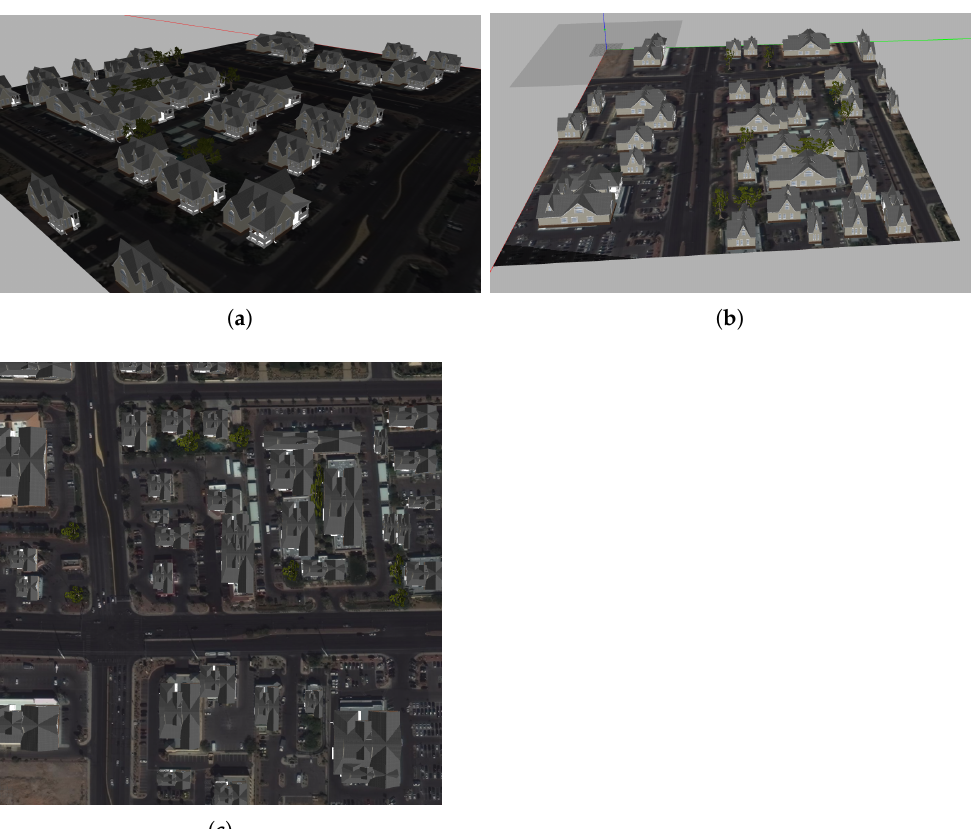
Figure 15. Gazebo results: ( a ) resulting Las Vegas satellite image modeled in Gazebo (angled view); ( b ) resulting Las Vegas satellite image modeled in Gazebo (mid view); and ( c ) resulting Las Vegas satellite image modeled in Gazebo (top view).